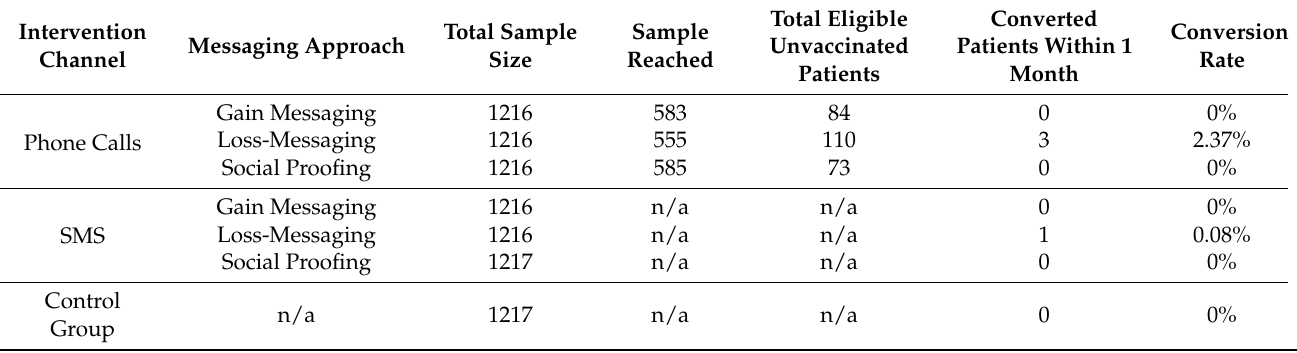
Table 3. Summary results for participants who responded to the call to